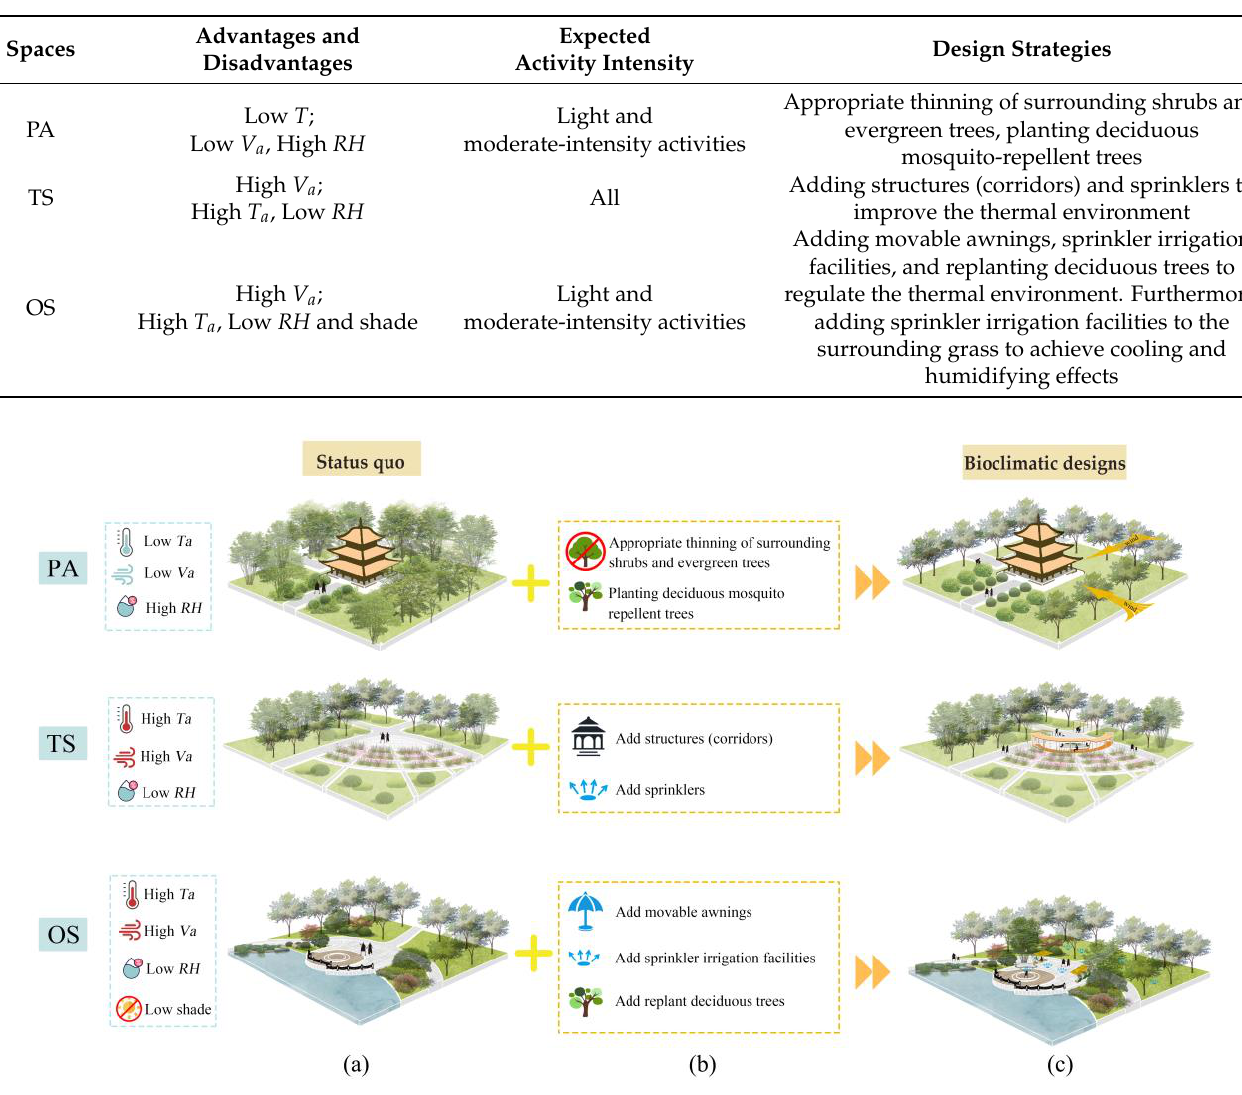
Table 11. Bioclimatic design strategies for the three outdoor spaces.